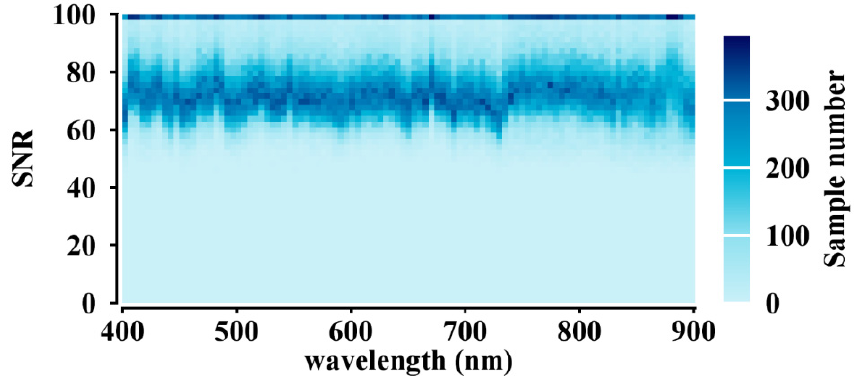
Figure 3. Performance of sparse representing method in dictionary dataset.